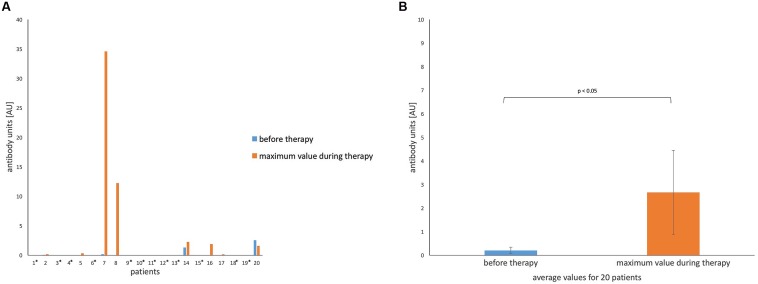
Levels of IgA anti-MS-1 phage antibodies in human sera. (A) Patients (n = 20) treated with S. aureus MS-1 phage cocktail. An asterisk next to the number of a patient means undetectable levels of antibodies before and during treatment. (B) Average values for patients treated with S. aureus MS-1 phage cocktail before and during treatment. Average values are plotted with the SE indicated by the error bars. The average value for 10 healthy donors was zero. Median value for the group of patients during treatment was zero as well.